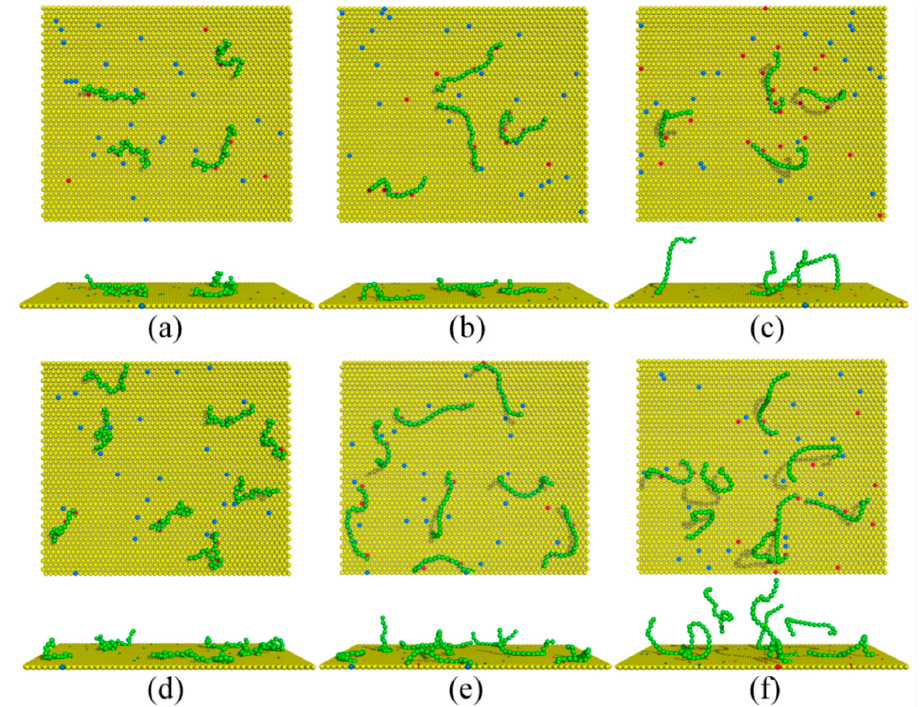
Figure 1. Equilibrated simulation snapshots of the polymers/monolayer complexes for the monolayer composition with PC:PS:PIP 2 = 98:1:1 for ( a – c ) C p = 0.00185 and ( d – f ) C p = 0.0037. Green spheres denote the polymer segments; yellow, blue, and red spheres represent the PC, PS, and PIP 2 lipid headgroups. The chain rigidity parameter κ of the polymers is set as ( a , d ) 0, ( b , e ) 10, and ( c , f ) 100, respectively.